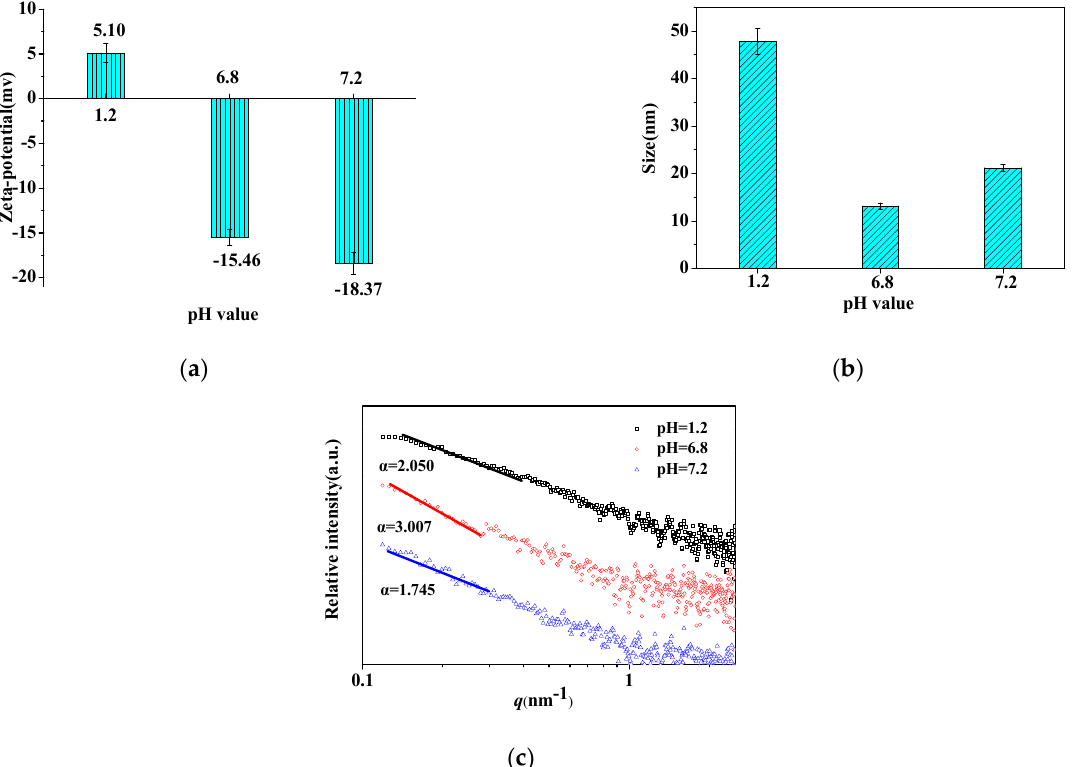
Figure 5. The surface potential ( a ), size distribution ( b ), and log I(q) − log q curve ( c ) of quintet − layer nanocapsule at GIT pH.